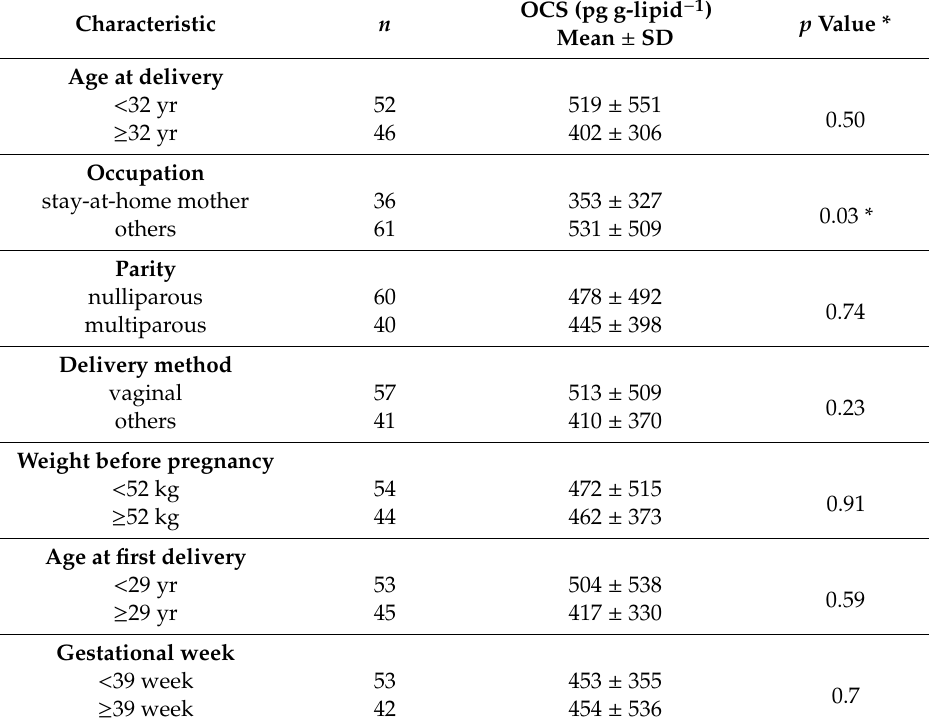
Table 3. Association between OCS and maternal characteristics at the collection of